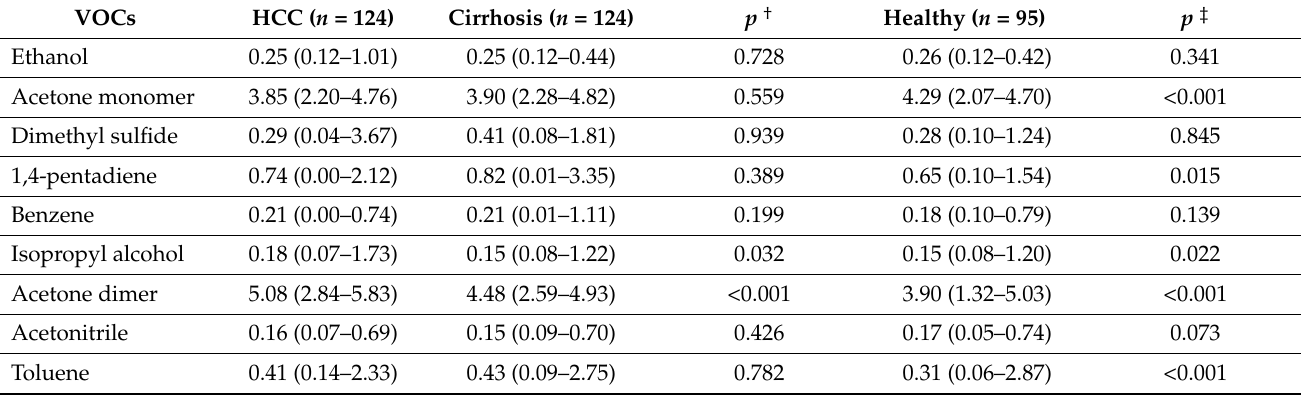
Table 2. VOC levels in HCC, cirrhosis, and healthy groups